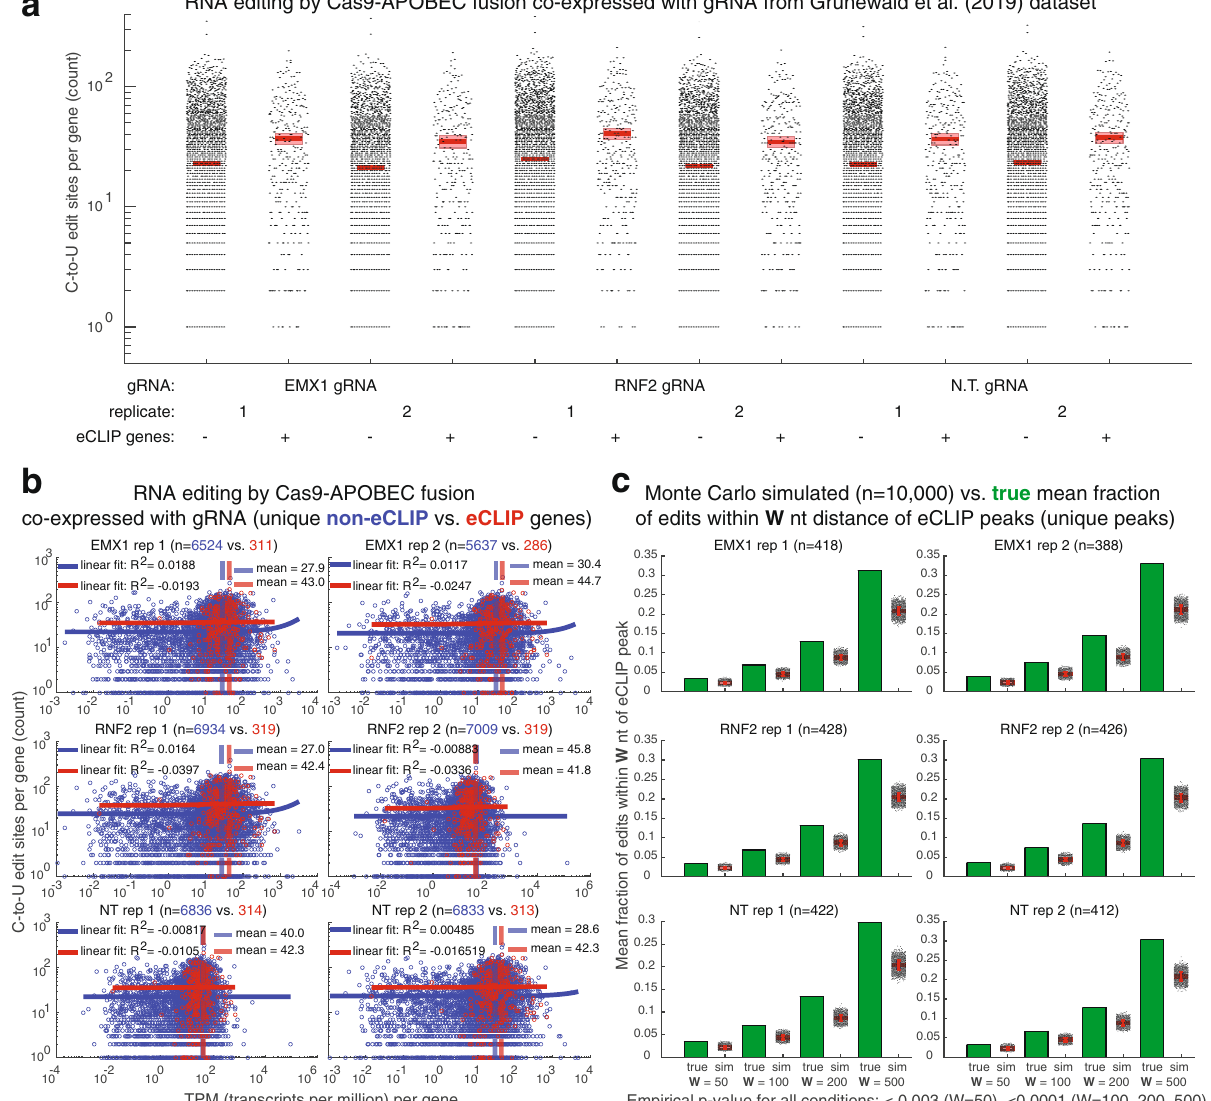
Fig. 3 Cas9-interacting human RNA transcripts reproducibly correlate with elevated transcriptome-wide RNA-editing activities at their target genes even under gRNA co-expression. a Box plots of C-to-U edit site counts per gene, for non-eCLIP vs. eCLIP genes. Data for each experimental condition (two replicates of three different gRNAs co-expressed with Cas9-APOBEC fusion) are plotted only of genes with at least one edit site according to Grünewald et al. 25 For each dataset mean is bold horizontal red line and 95% con fi dence interval is lighter red box. (Invisible plotted con fi dence intervals are within plotted means.) b Scatter plot based on a TPM (transcripts per million) per gene vs. C-to-U edit site counts per gene, for non-eCLIP (blue) vs. eCLIP (red) genes. Linear fi ts with R 2 values of each dataset by gene type are plotted in solid lines, whereas TPM means of each dataset by gene type are plotted in dashed lines. c Plots of the predictions of Monte Carlo simulated (10,000 simulations) vs. true mean fraction of edits within W (50, 100, 200, 500) nt distance of each eCLIP peak represented in a whose center is on a spliced RNA transcript to each C-to-U edit site on that transcript. Empirical p - value <0.003 for W = 50 for all conditions; <0.0001 for W = 100, 200, 500 for all conditions (Monte Carlo simulation). For Monte Carlo simulations, simulated eCLIP peaks were placed along the spliced RNA transcript according to a uniform random distribution. True mean fractions of edits are represented by green bars, while the Monte Carlo simulations are represented by scatter, where the mean is a bold horizontal red line superimposed with red standard deviation error